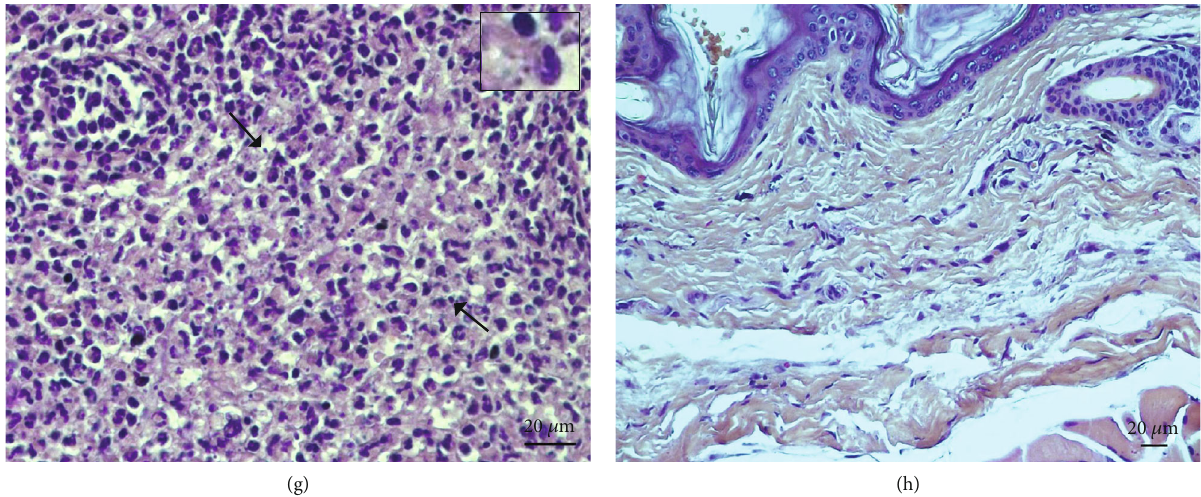
Figure 3: Skin histological section from infected controls: (a) infected, nontreated, (b, c) infected and treated with blank SNEDDS or blank SNEDDS gel, respectively, and animals treated with BUT-SNEDDS or BUT-SNEDDS gel (d, e, respectively), butena fi ne (f), or Glucantime (g). Skin histological section from healthy animals is shown in (h). Black arrows indicate intracellular amastigote forms. Insets show in details amastigote forms of the skin histological sections from animals treated with butena fi ne loaded in gel (e) or Glucantime (g).